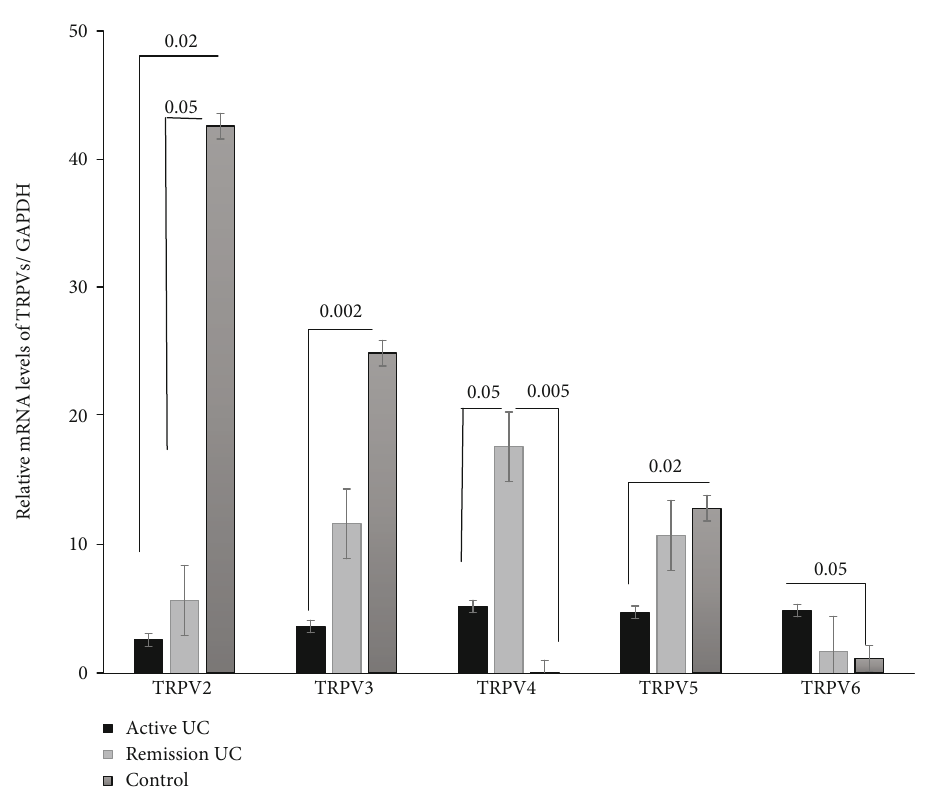
Figure 1: TRPV2, TRPV3, TRPV4, TRPV5, and TRPV6 gene expression quanti fi ed by RT-PCR in colonic mucosa from patients with active and remission UC compared to non-IBD controls. Bars show mean ± standard error of the mean of transcript levels from UC patients with GAPDH as constitutive gene determined by 2 - ΔΔ Ct . ∗ P value < 0.05 was considered as signi fi